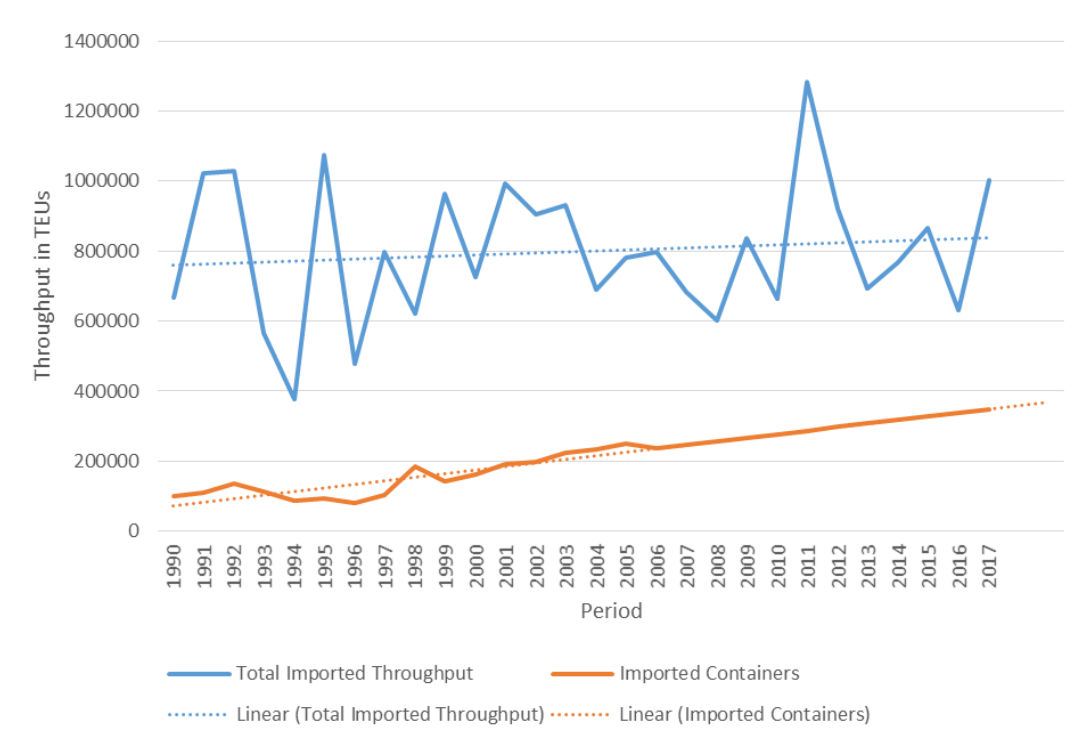
Figure 4: Relationship between the year and total imported container traffic